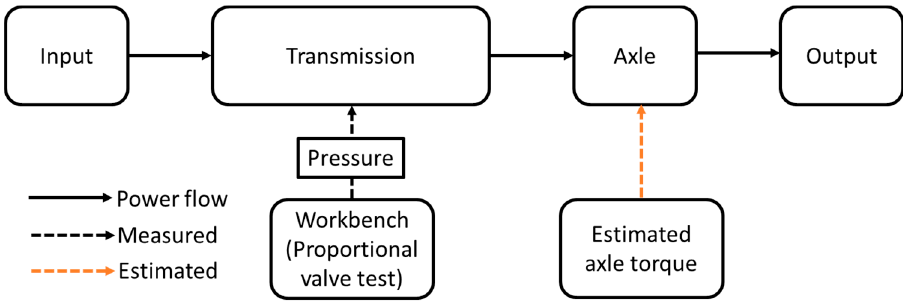
Figure 6. The schematic diagram for applied simulation conditions in this study.